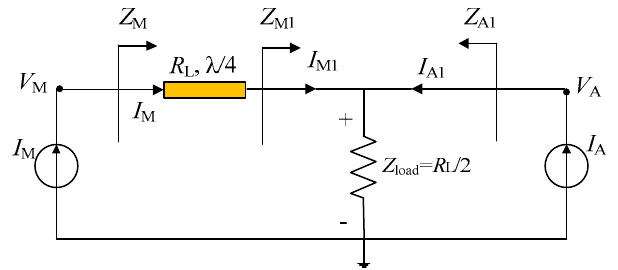
Figure 1. Conventional DPA topology.